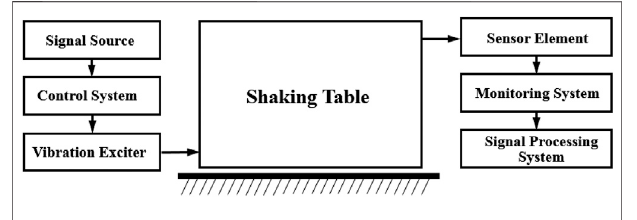
FIGURE 1 | Principle of shaking table test.